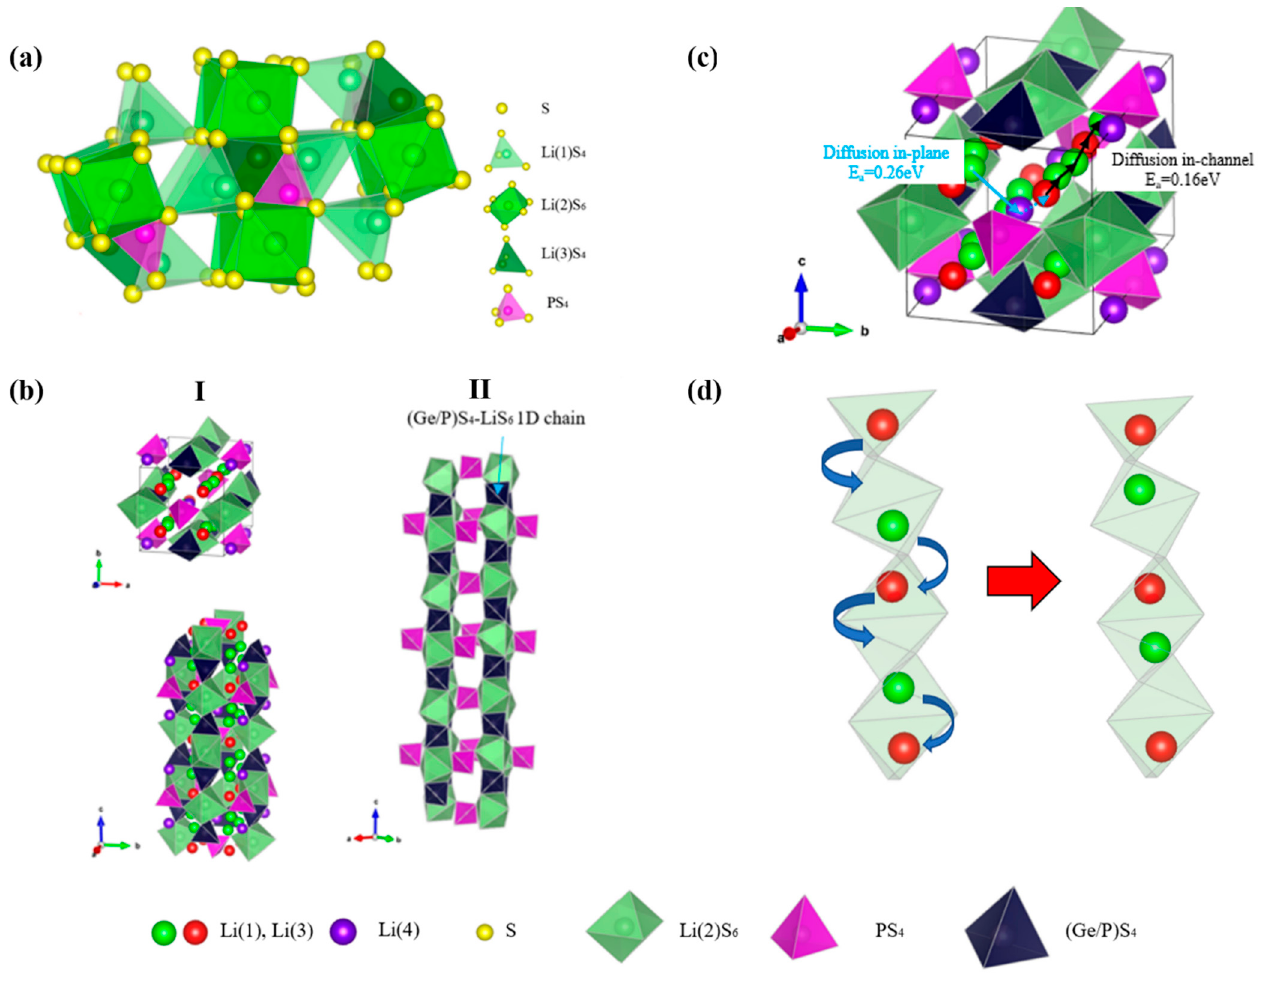
Figure 7. ( a ) Crystal structure of β‐ Li 3 PS 4 . ( b ) Crystal structure of Li 10 GeP 2 S 12 . (I) Structure of Li 10 GeP 2 S 12 and lithium ions involved in ionic conduction. (II) Framework of Li 10 GeP 2 S 12 . ( c ) Schematic of two Li + ion diffusion modes in Li 10 GeP 2 S 12 . ( d ) Schematic of the correlated hopping of Li ions diffusion in the channel.